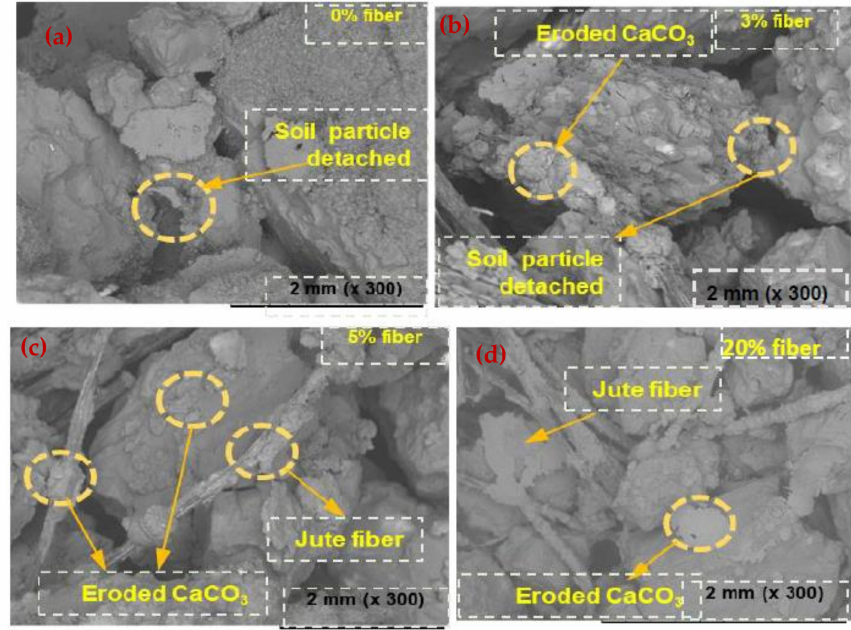
Figure 8. SEM images (DW) of the specimens after exposure to WD cycles. ( a ) 0% fiber; ( b ) 3% fiber; ( c ) 5% fiber and ( d ) 20% fiber.